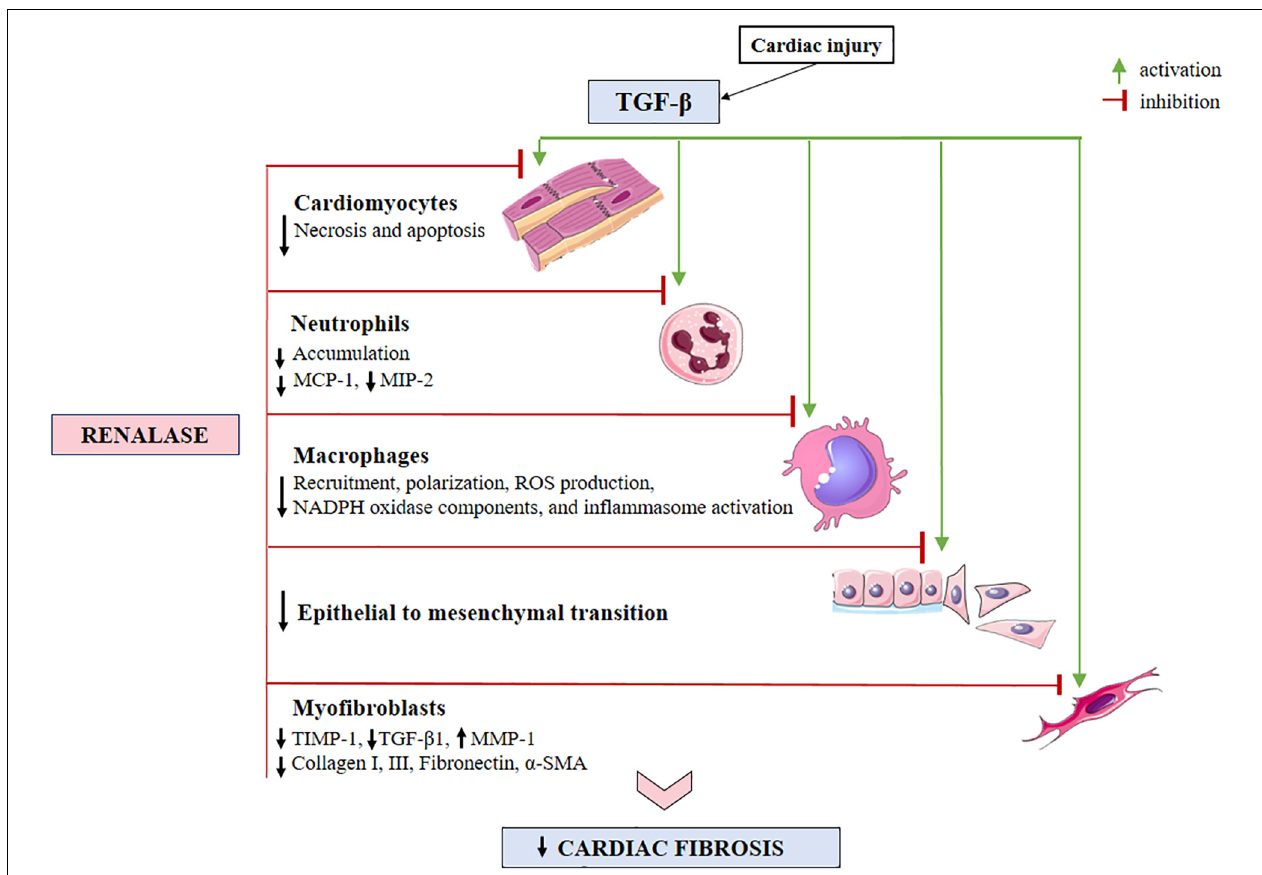
FIGURE 2 | A schematic view of the TGF- β -activated cellular effectors, with respect to anticipated sites for renalase action within the injured myocardium. Evidence has shown that renalase both inhibits necrosis and apoptosis, while diminishing neutrophil infiltration. Renalase lessens total macrophage accumulation, particularly the M1-like (pro-inflammatory) sub-type, and likely serves to promote M2-like (anti-inflammatory) phenotypes, suppressing inflammasome activation. Additionally, renalase downregulates the expressions of MCP-1, MIP-2, and NADPH oxidase components (gp91 phox , p47 phox , and p67 phox ), suppresses epithelial to mesenchymal transition, and decreases the expression of α -SMA, collagen I, and III, TIMP-1 and TGF- β -1, while increasing the expression of MMP-1. TGF- β , transforming growth factor- β ; MCP-1, monocyte chemoattractant protein - 1; MIP-2, macrophage inflammatory protein-2; ROS, reactive oxygen species; NADPH, nicotinamide adenine dinucleotide phosphate; TIMP-1, tissue inhibitor of metalloproteinase-1; MMP-1, matrix metalloproteinase-1; α -SMA, α -smooth muscle